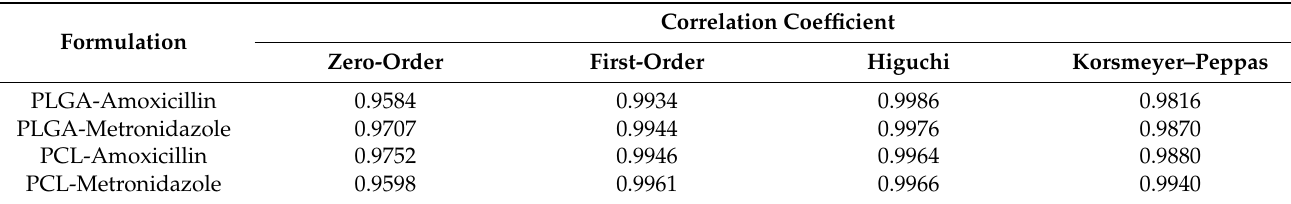
Table 1. The correlation coefficients obtained by fitting the drug release data from the nanofibers to the zero-order, first-order, Higuchi, and Korsmeyer–Peppas